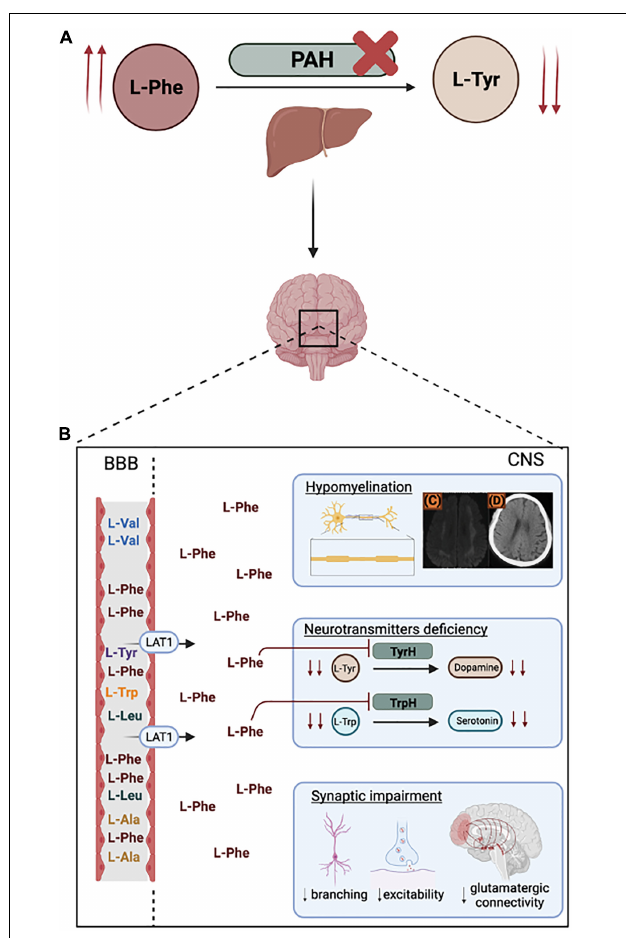
FIGURE 1 | Phenylketonuria (PKU) pathophysiology. (A) Metabolic impairment of phenylalanine hydroxylase (PAH) in the liver leads to increased plasmatic phenylalanine (L-Phe) (hyperphenylalaninemia) and decreased tyrosine (L-Tyr). (B) At the Blood Brain Barrier (BBB), L-Phe competes with higher affinity for the L-type amino acid transporter (LAT-1), leading to neurotoxic L-Phe levels in the Central Nervous System. Hyperphenylalaninemia negatively impacts myelinating processes [ (C) and (D) represent low-density whyte matter lesions and temporal/frontal lobes atrophy in a late-diagnosed child (adapted from Chen et al., 2019)] and leads to neurotransmitters deficiencies and synaptic impairment. Figure created with